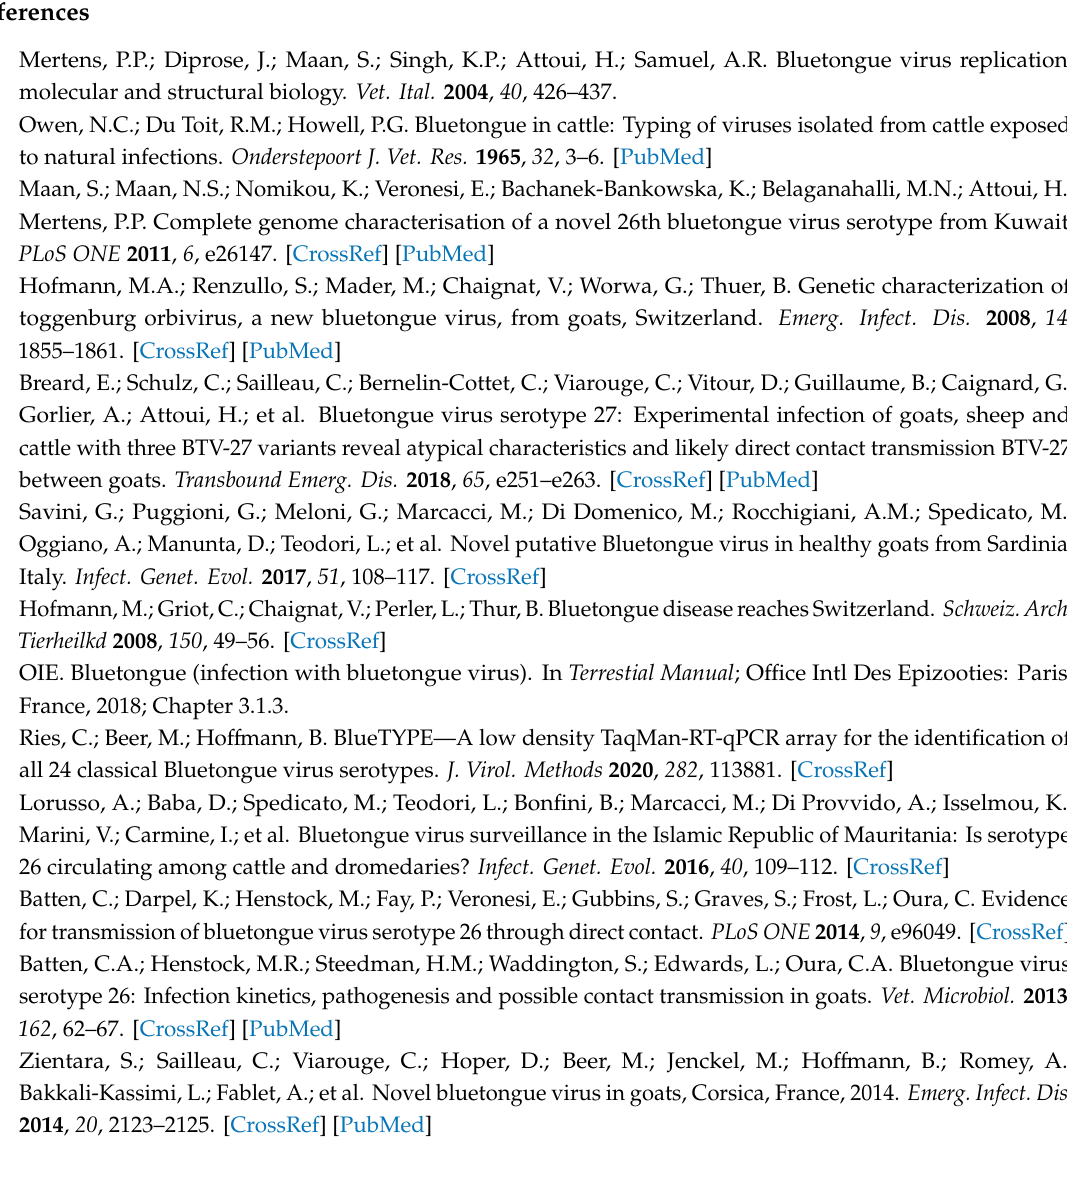
Table S1: All BTV-25 specific RT-qPCR (Cq value) and cELISA (S / N%) results of the goat herd over